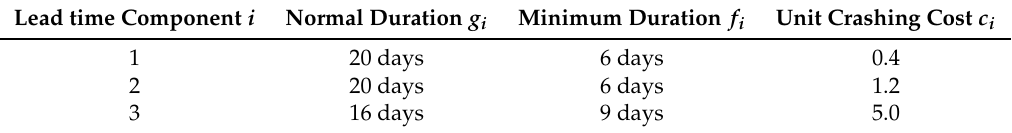
Table 2. Data for lead time demand.